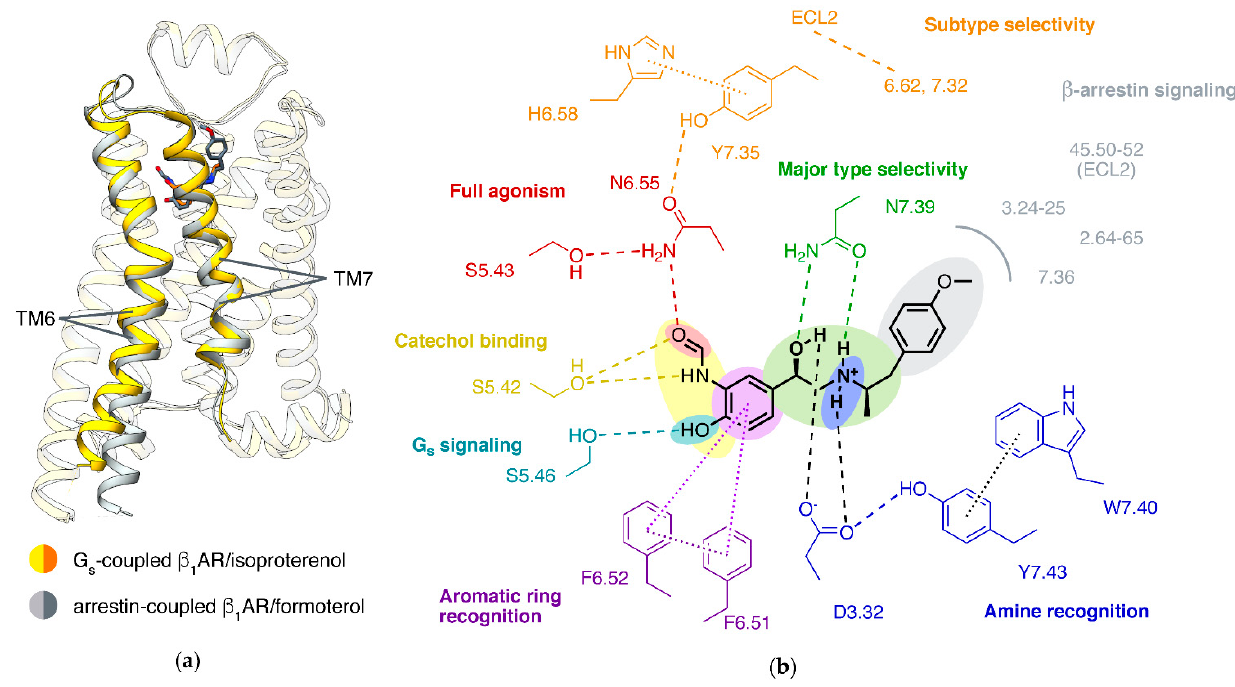
Figure 5. Mechanisms of effects of ligands on β adrenergic receptors. ( a ) Structures of β 1 AR coupled to G s or arrestin (PDB IDs: 7JJO [66], 6TKO [11]) ( b ) Sketch map of key ligand interactions in β ARs. Formoterol in β 2 AR was used for the draw- ing.